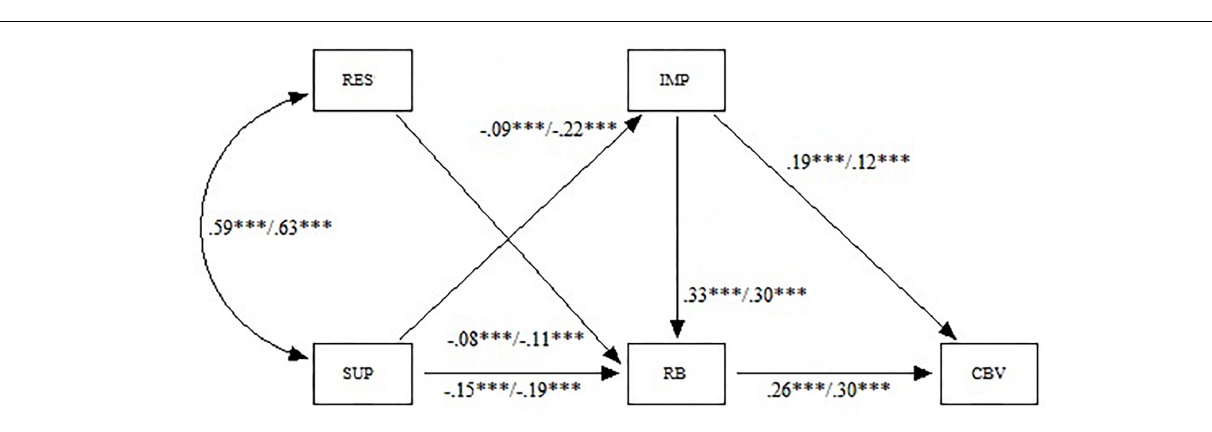
in the case of restriction and small